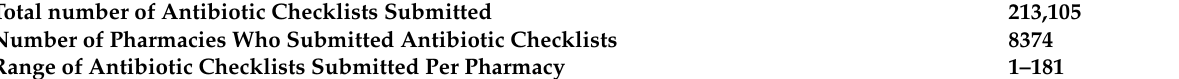
Table 2. Summary of the numbers of TARGET Antibiotic Checklists submitted by participating pharmacies.